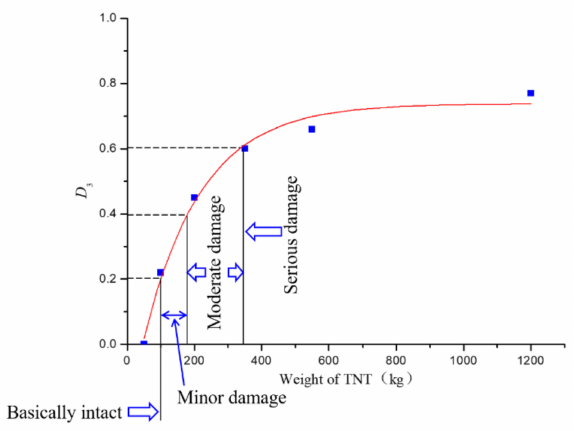
Figure 12. The degree of damage to the abutment for different masses of explosive. The mass of the explosive corresponding to the state of local damage to the abutment can be calculated from Equation (8), as shown in Figure